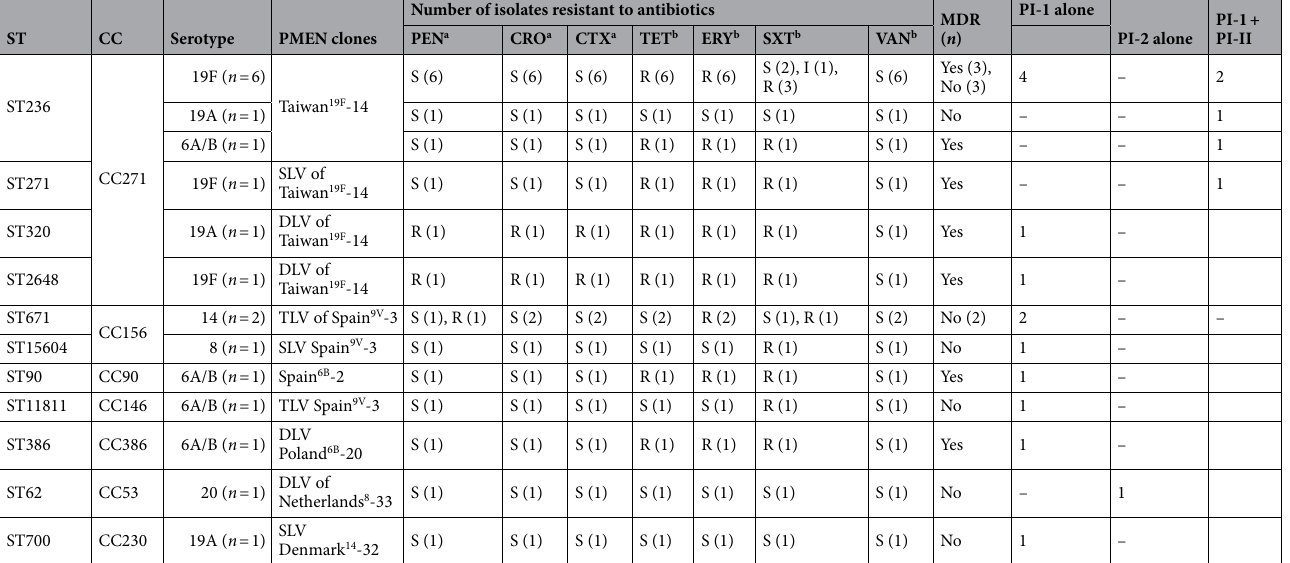
Table 3. Genotypic characteristics of the piliated pneumococcal isolates in relation to serotypes and antibiotic susceptibilities. ST sequence type, CC clonal complex, PMEN Pneumococcal Molecular Epidemiology Network, SLV single-locus variant, DLV double-locus variant, TLV triple-locus variant, PEN penicillin, TET tetracycline, ERY erythromycin, CRO ceftriaxone, CTX cefotaxime, SXT trimethoprim-sulfamethoxazole, VAN vancomycin., MDR multidrug resistance; a Susceptibility test by E-test (MIC determination) for penicillin, ceftriaxone and cefotaxime. b Susceptibility test by disk diffusion for tetracycline, erythromycin, trimethoprim- sulfamethoxazole and